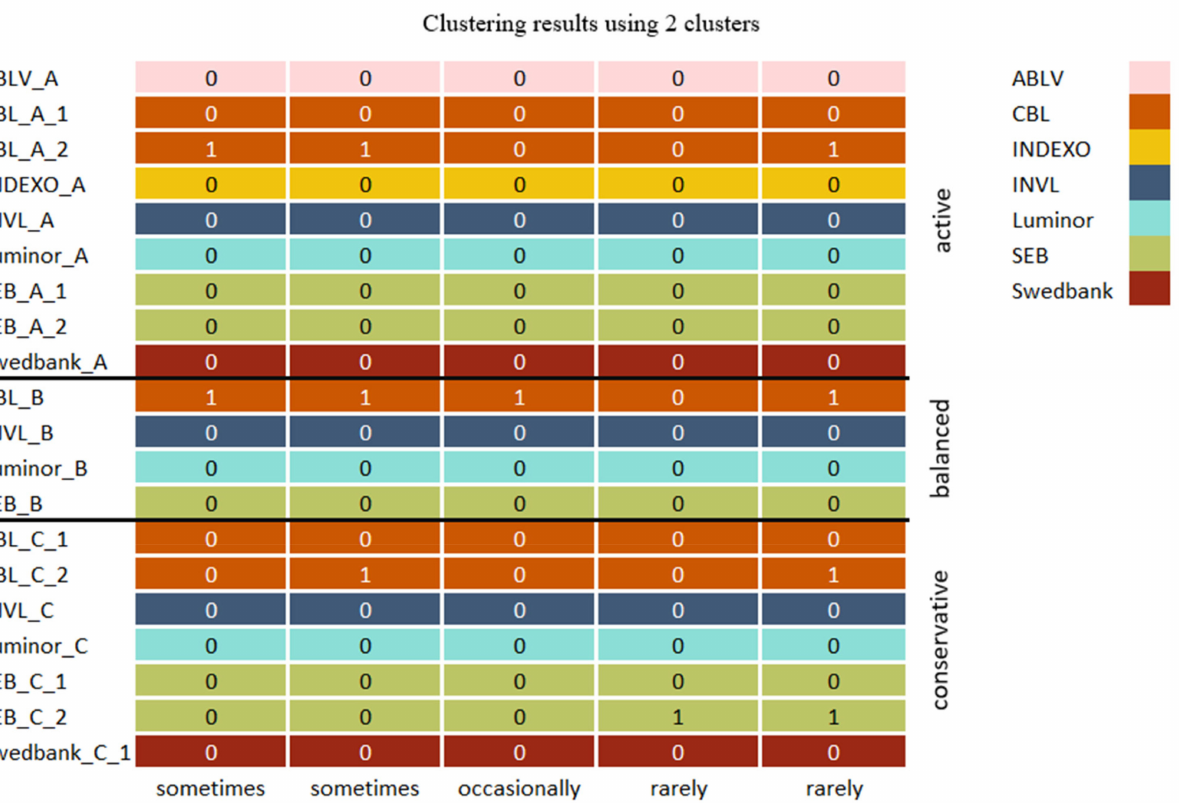
Figure 13. The frequencies of different cluster combinations using other clustering algorithms with omitted OPTICS results clustered the dataset into two clusters with silhouette scores above the mean